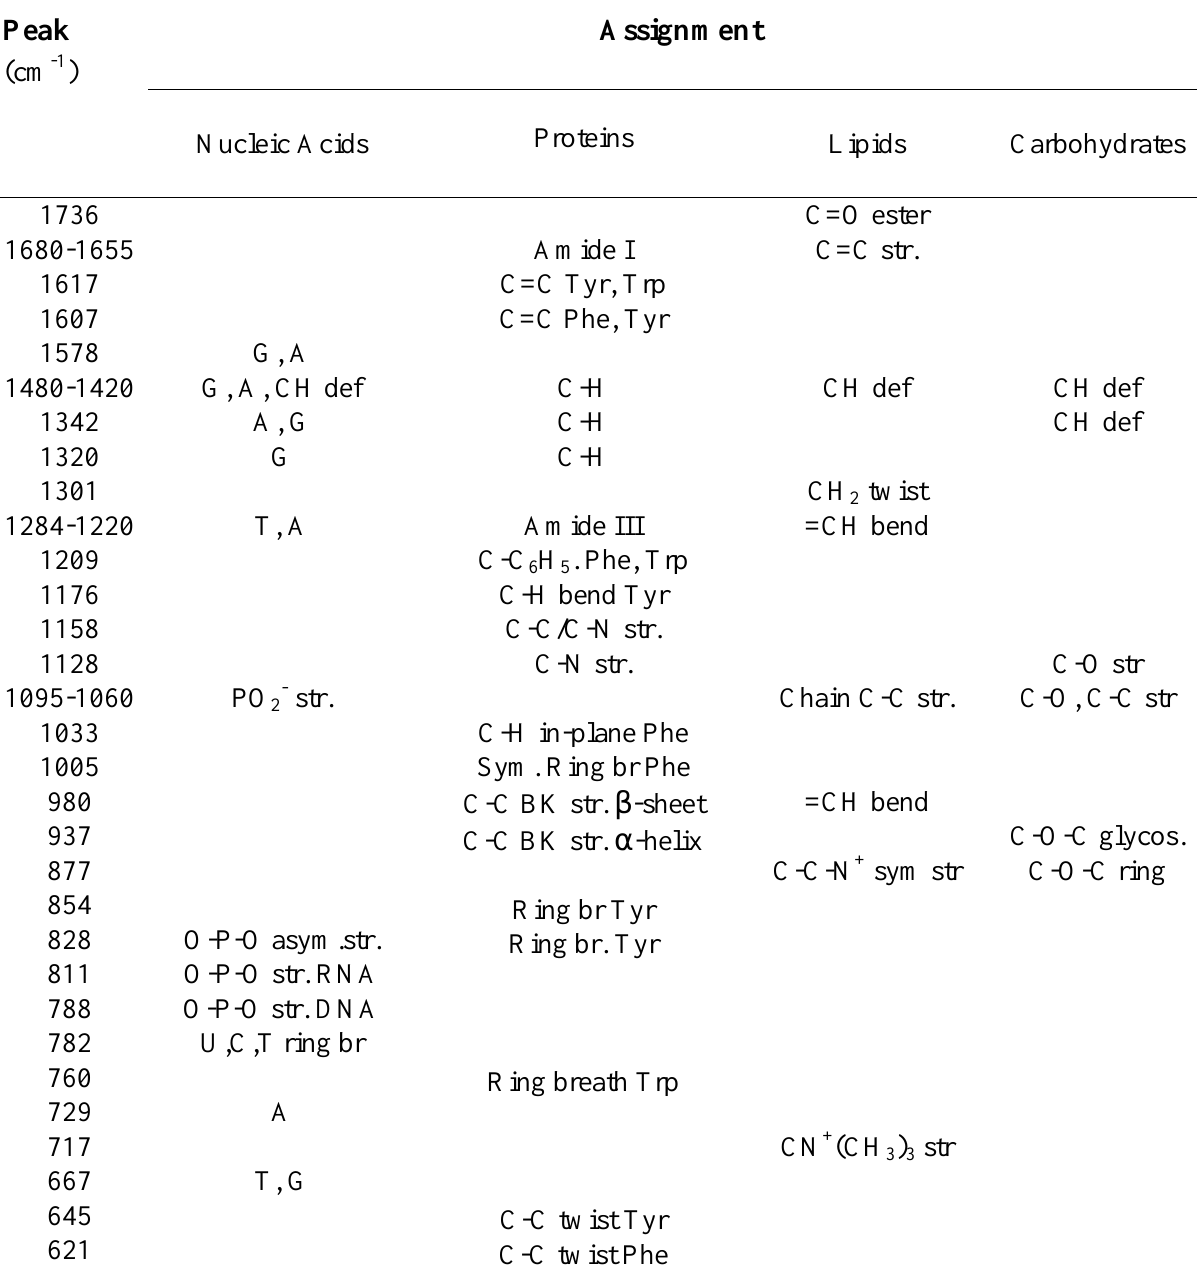
Table 1 . Peak assignment for Raman spectra of living cells